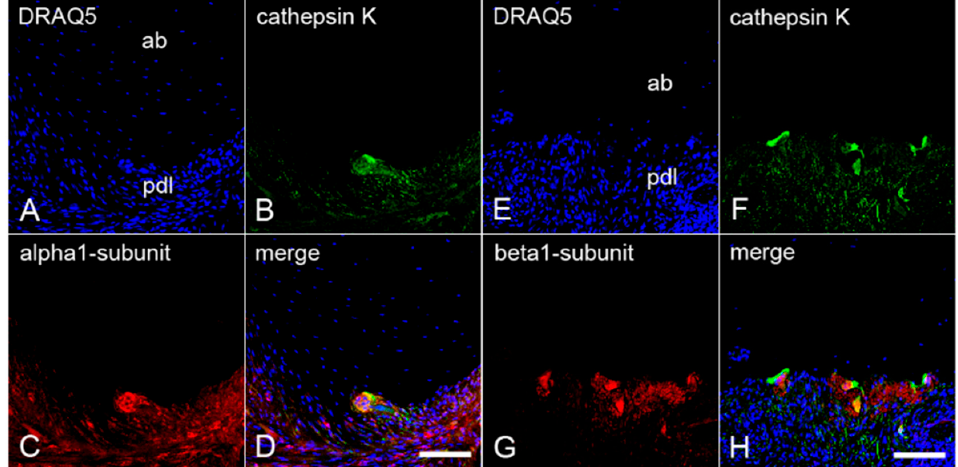
Figure 6. Colocalization of the α 1 - and β 1 -subunits of sGC with cathepsin K in osteoclasts of inflamed human periodon- tium: sections of a representative molar with adherent clinically inflamed periodontium were stained with DRAQ5 ( A , E ) and incubated with antibodies for cathepsin K ( B , F ), α 1 -subunit ( C ), and β 1 -subunit ( G ) of sGC. Colocalization of cathepsin K with the α 1 -subunit ( D ) and β 1 -subunit ( H ) in osteoclasts is depicted in the merged images. ab = alveolar bone, and pdl = periodontal ligament. Scale bar = 100 µm ( D , H ).